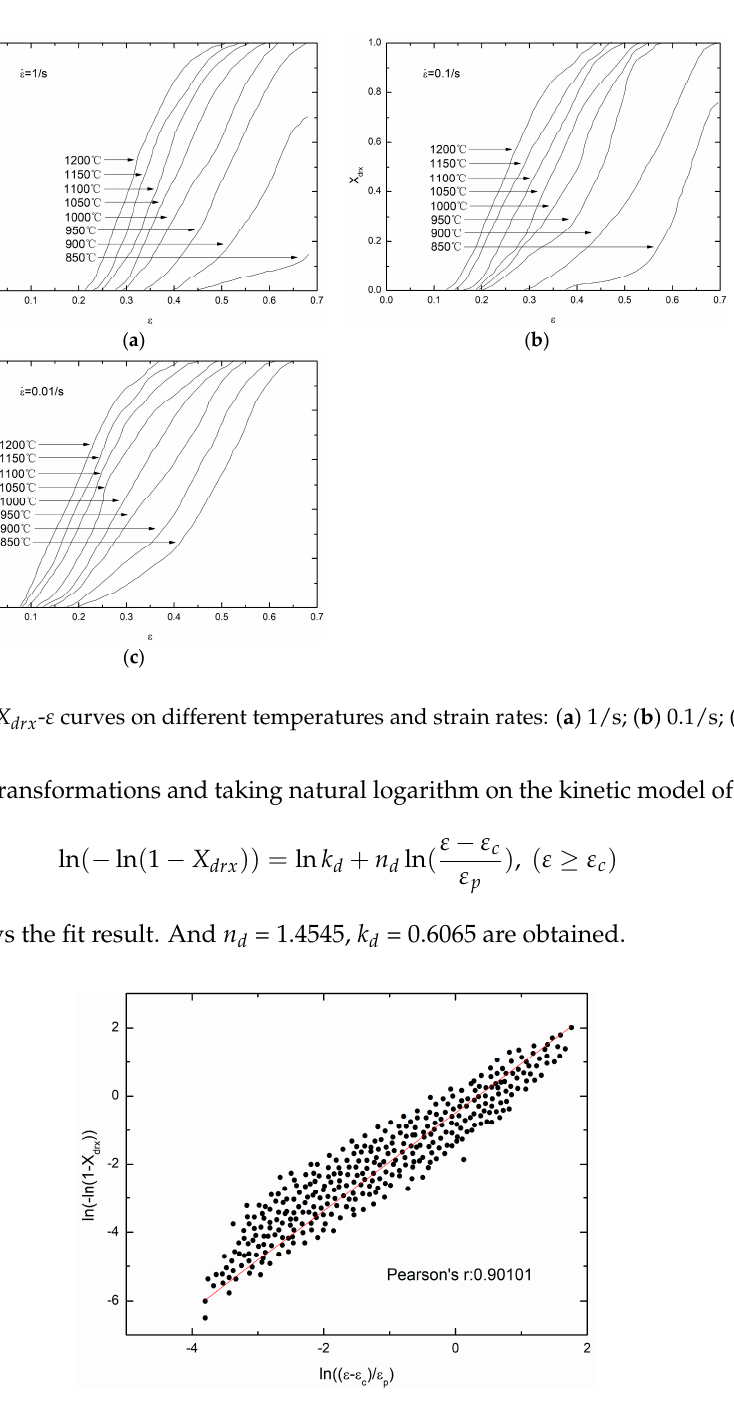
ε ε ε− . Figure 14. The relationship between ln ( − ln ( 1 − X )) and ln ( ε − ε c ) drx ε p p